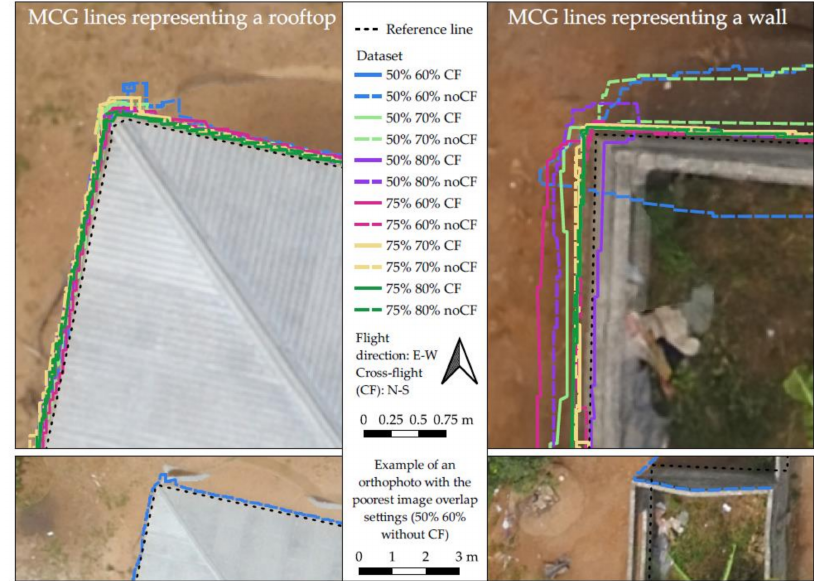
Figure 9. Example showing the di ff erences of automatically extracted rooftops and walls separated according to flight configuration (forward overlap (%), side lap (%)) and flight pattern (CF = cross flight, noCF = no cross flight).